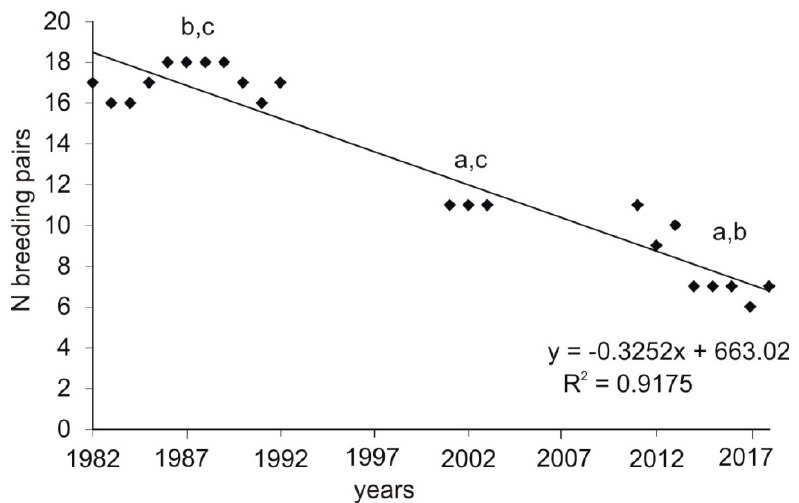
Figure 2. The number of breeding pairs recorded in the whole area of study (central Poland, vicinity of Rogów village, Experimental Forest Station of Warsaw University of Life Sciences) in the three compared periods: 1) 1982 – 1992 [19], 2) 2001 – 2003 [24], and 3) 2011 – 2018 (current study). The letters show the changes between the three study periods (a for 1982 – 1992, b for 2001 – 2003, and c for 2011 – 2018) as indicated by a Mann–Whitney post hoc test. Table 2. The average number of breeding pairs in the three compared periods in seven forest complexes and in the whole area of study (central Poland, vicinity of Rog ó w village, Experimental Forest Station of Warsaw University of Life Sciences): The numbers of the forest complexes are as indicated in Figure 1 (map of the study area). The data are for 1982–1992 [19], 2001–2003 [55], and 2011–2018, the current study. The SD values are given when the data were available. Study Forest Complex